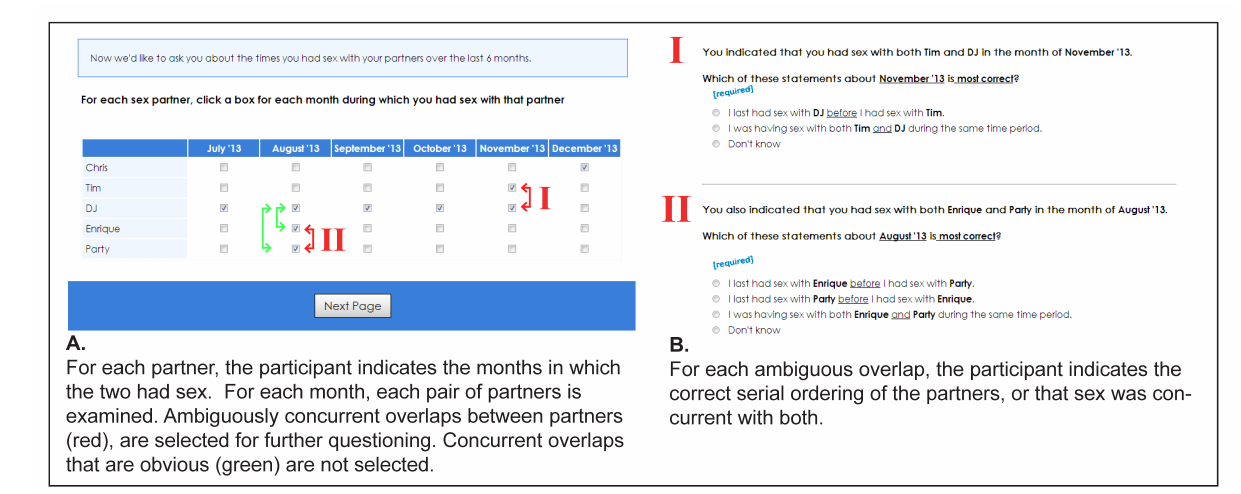
Figure 2. Screenshots of the online partnership timing module illustrating the method for offering follow-up clarification questions.